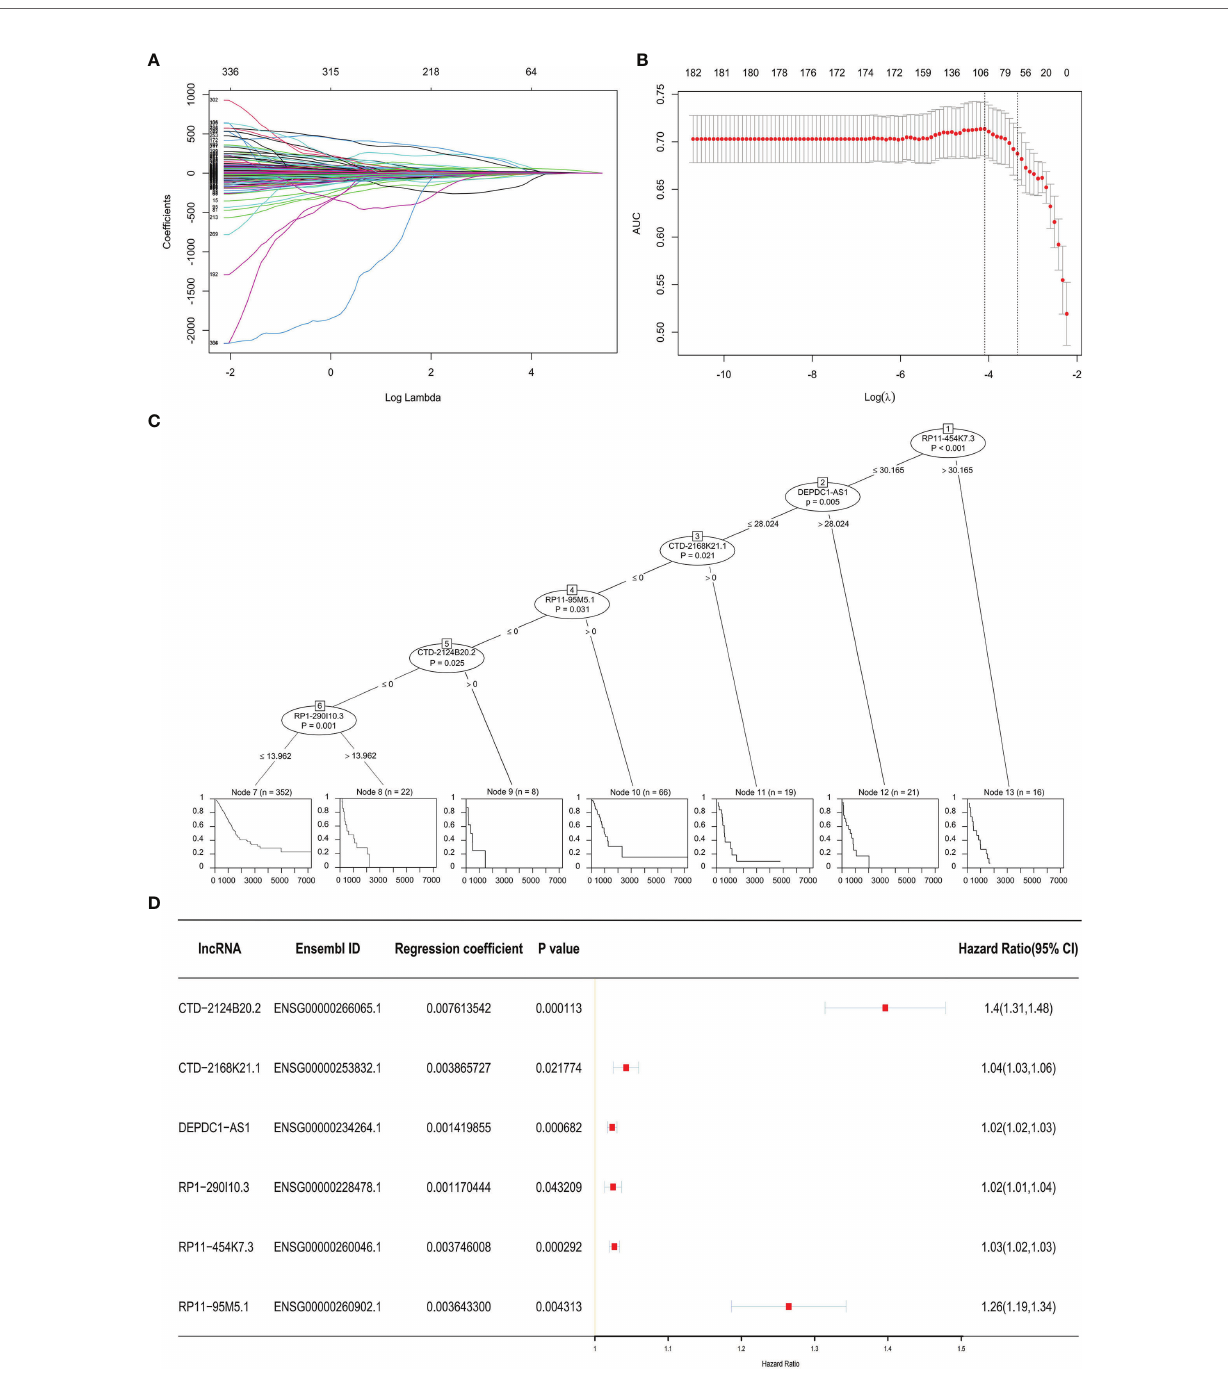
FIGURE 1 | Prognostic model. (A) Least absolute shrinkage and selection operator (LASSO) coef fi cient distribution diagram of 336 long non-coding RNAs (lncRNAs): x -coordinate was log ( l ) for screening the best tuning parameter ( l ). (B) Tuning parameter ( l ) in the LASSO regression model was selected according to 10-fold cross-validation. Plotting was performed based on this value as well as the area under the receiver operating characteristic curve. A vertical dashed line was drawn at the best value by using the minimum standard and 1 standard error of the minimum standard (1-SE standard). (C) Visualization of the Cox regression analysis: the signi fi cant lncRNAs ( P < 0.05) in the Cox regression were displayed. The impacts of these lncRNAs on the prognosis of lung adenocarcinoma (LUAD) patients are shown below by a single survival curve. (D) Forest map with HR: the Ensembl ID of the six lncRNAs, regression coef fi cient in LASSO regression, and P -value in the Cox regression analysis were displayed; a vertical line was drawn at HR =